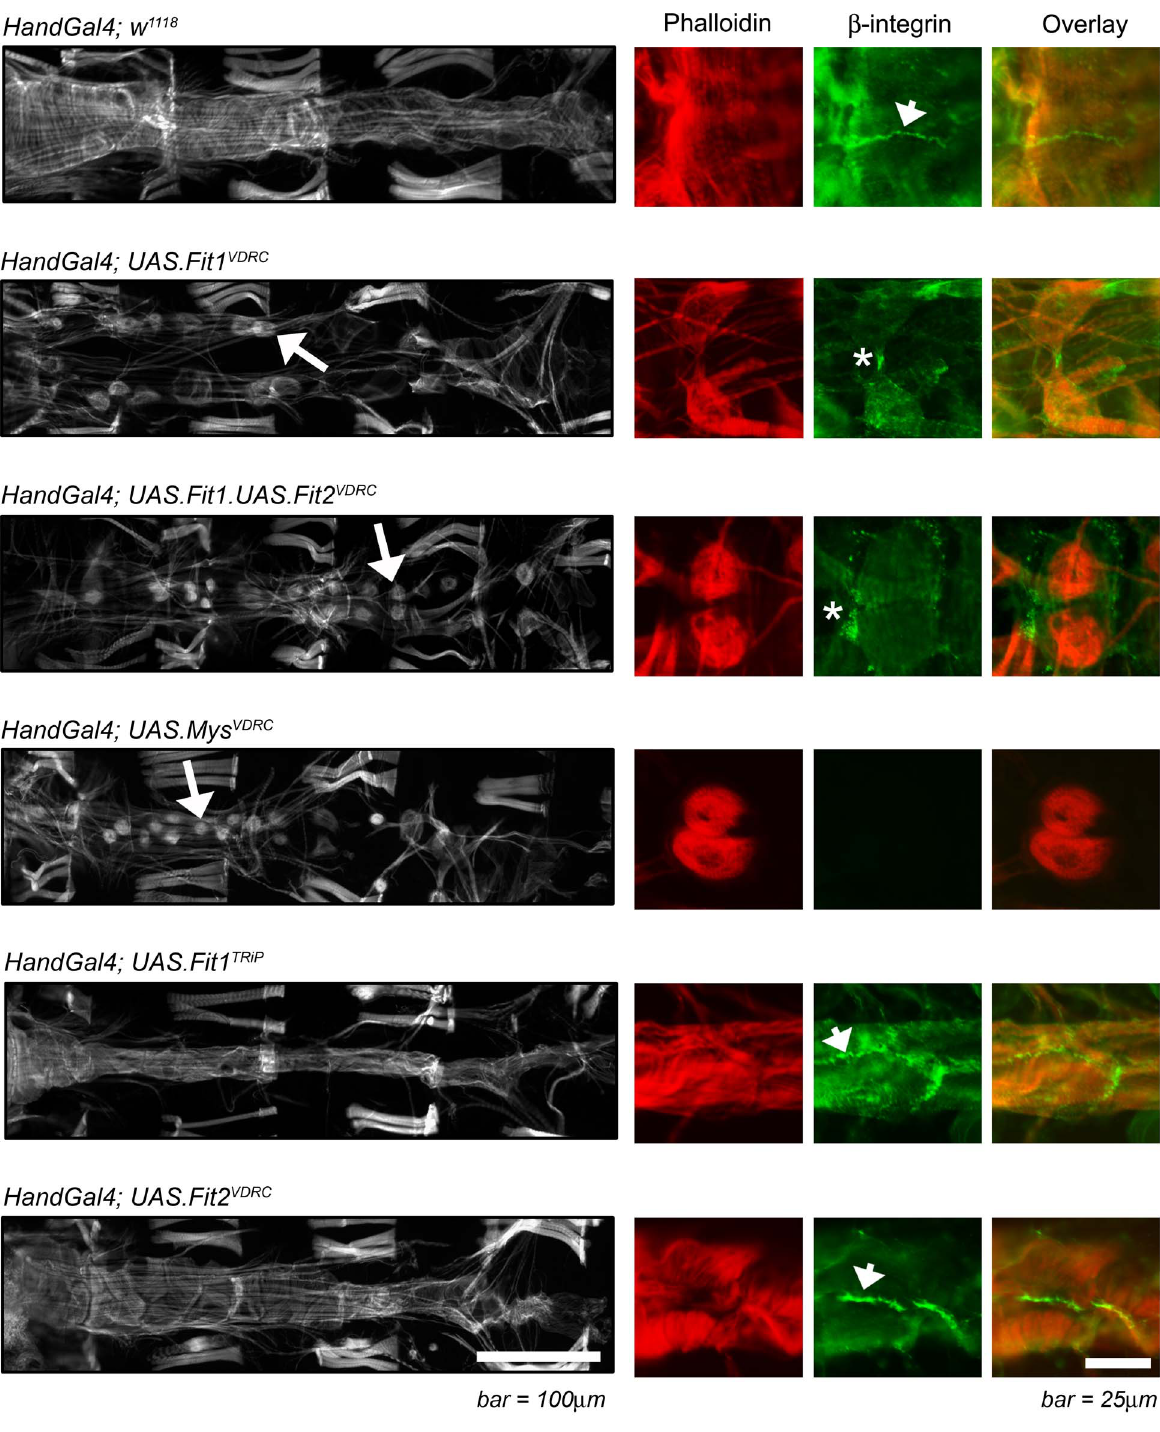
Figure 2. Fermitins regulate coupling between cardiomyocytes. The monochrome micrographs show the adult Drosophila heart (segments A2 to A5) stained with phalloidin, oriented with the anterior region to the left. Genes were silenced using the Hand-Gal4 enhancer which drives expression in cardiomyocytes (as well as pericardial nephrocytes and enterocytes of the gut) and abnormal cardiomyocyte/heart morphology is highlighted by the arrows. The colour panels show higher magnification micrographs of at least two cardiomyocytes stained with phalloidin (red) and antibodies to the Drosophila b -integrin, myospheroid (green); arrowheads indicate normal integrin staining between cardiomyocytes; asterisks indicate an abnormal staining pattern associated with loss of cardiomyocyte junction integrity. A wild type phenotype ( Hand-Gal4; w 1118 ), is characterised by contiguous cardiomyocytes and b -integrin staining between cardiomyocytes.